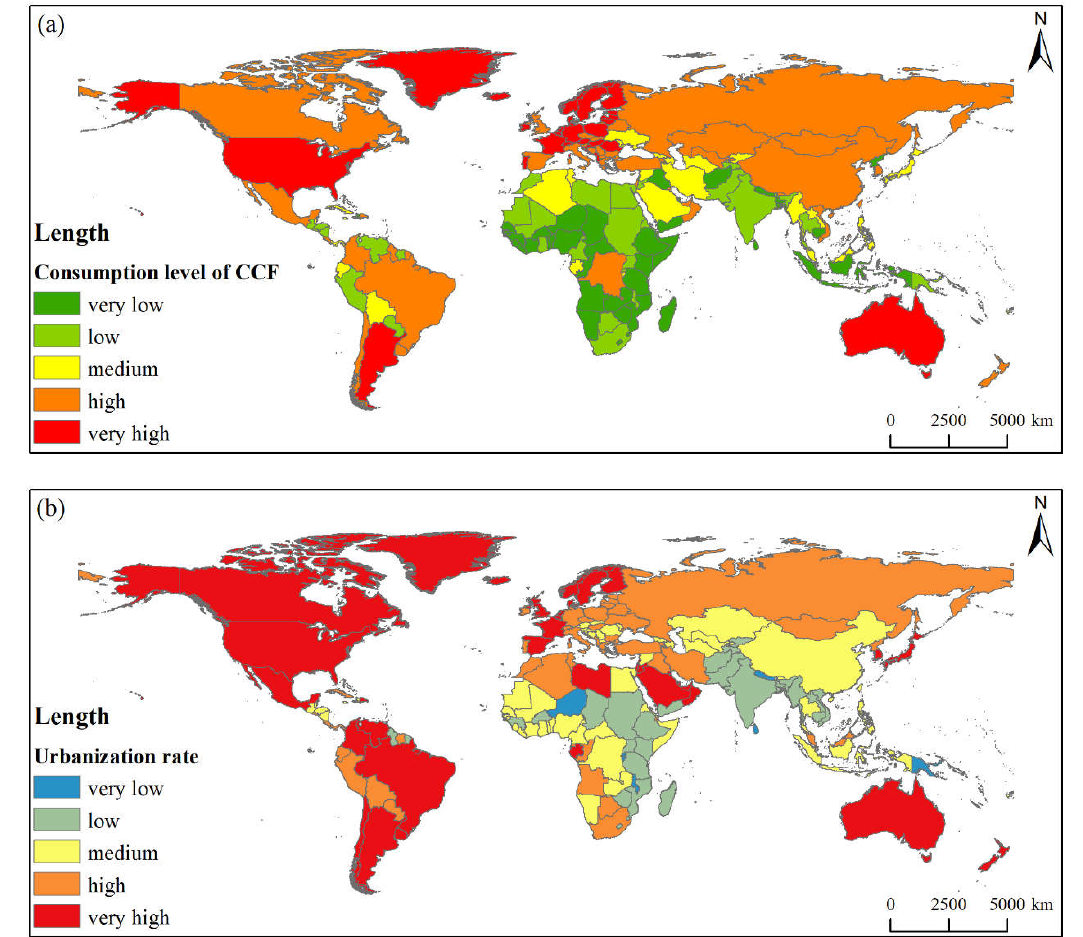
Figure 2. Spatial patterns of CCF consumption level ( a ) and urbanization level ( b